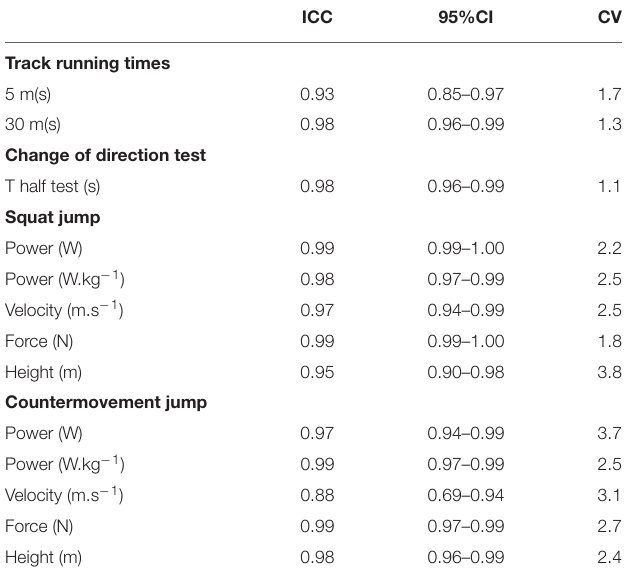
TABLE 3 | Inter-class correlation coefficient (ICC, 95% confidence limits) and coefficient of variation (CV), showing acceptable reliability for measures of track running velocity, change of direction, squat jump and countermovement jump